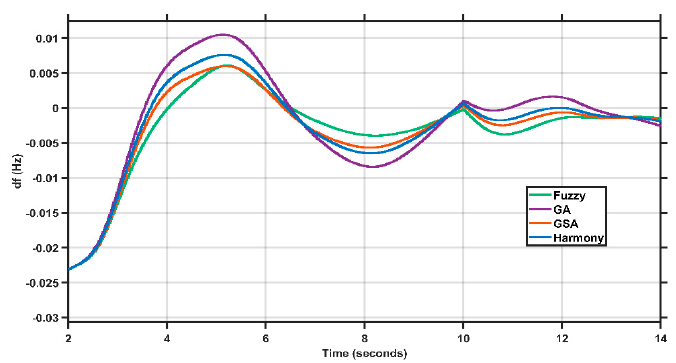
Figure 15. The scoped frequency deviation results under wind disturbance.